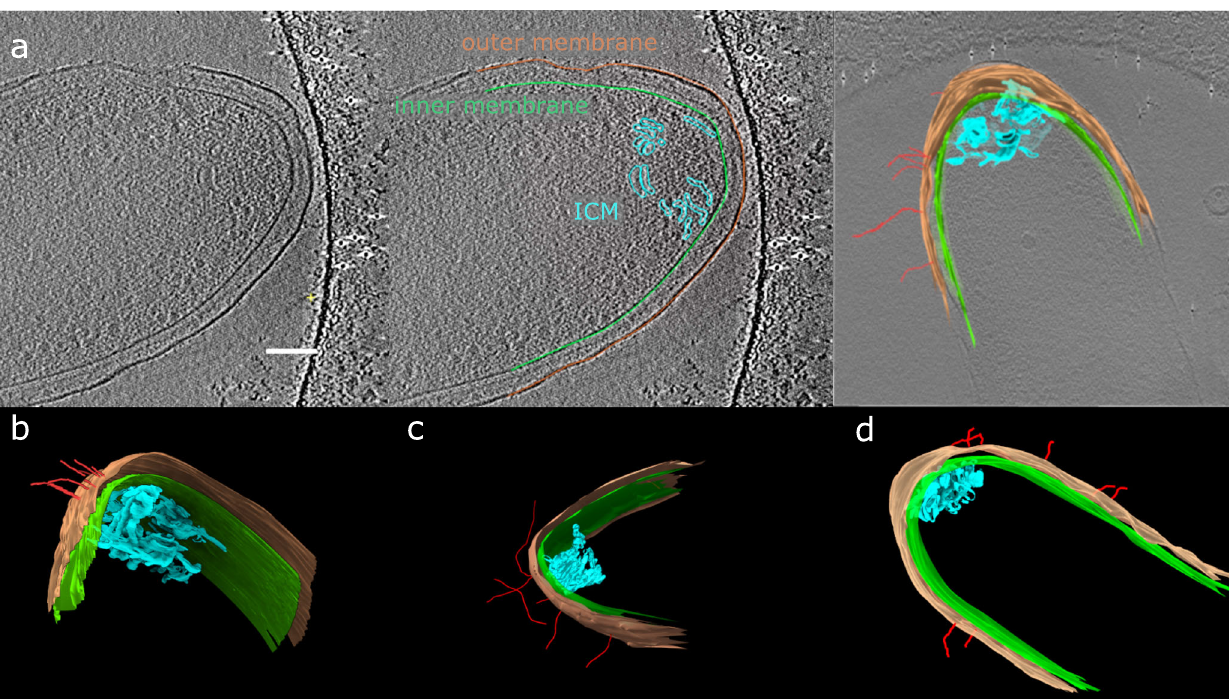
Fig. 2 3D segmentation of ICM in anode-grown G. sulfurreducens . a Tomogram slices illustrating how 3D models were created via tomogram segmentation of ICM located in the tip of a G. sulfurreducens cell with the inner membrane, outer membrane, ICM, and several nanowires modeled from the tomogram. The scale bar is 100 nm. b – d 3D models of three separate cells displaying ICM near the tip of each cell. These cells were grown at − 0.07 V vs. SHE directly on a